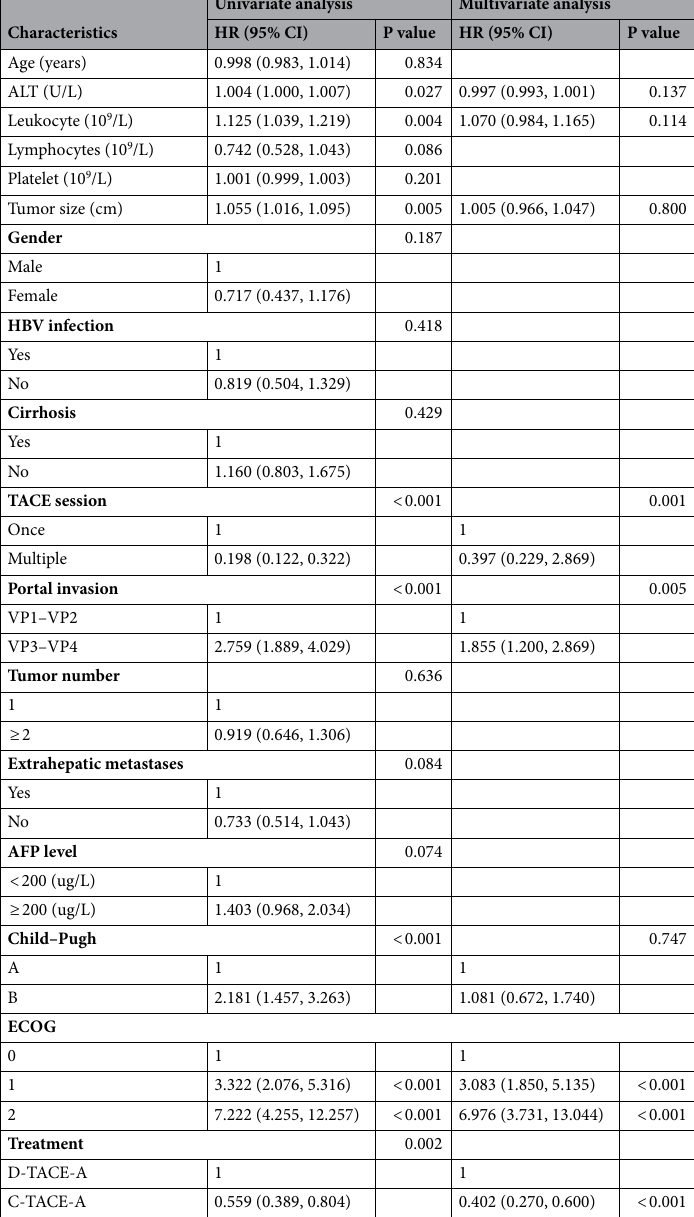
Table 4. Univariate regression analysis and multivariate regression analysis for PFS before